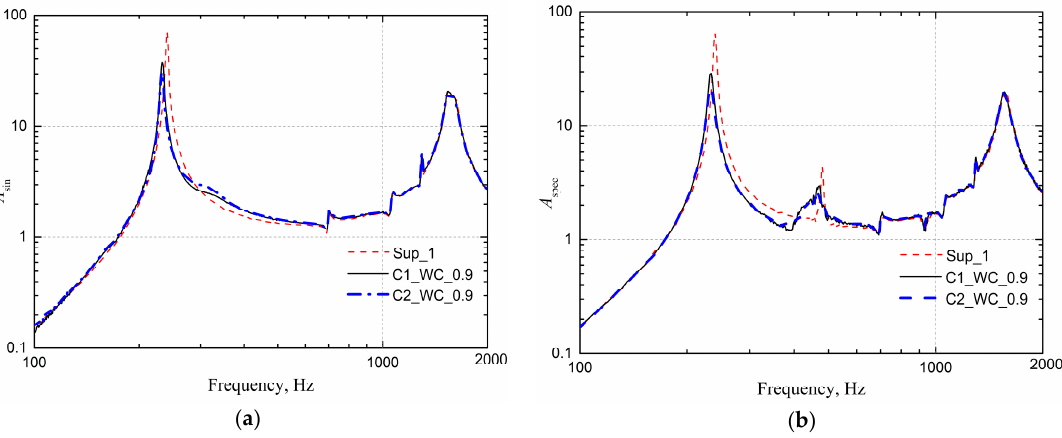
Figure 11. Experiment results of Tungsten carbide powder (layering in Y-direction of the cavity); ( a ) Sinusoidal excitation; ( b ) Random excitation.